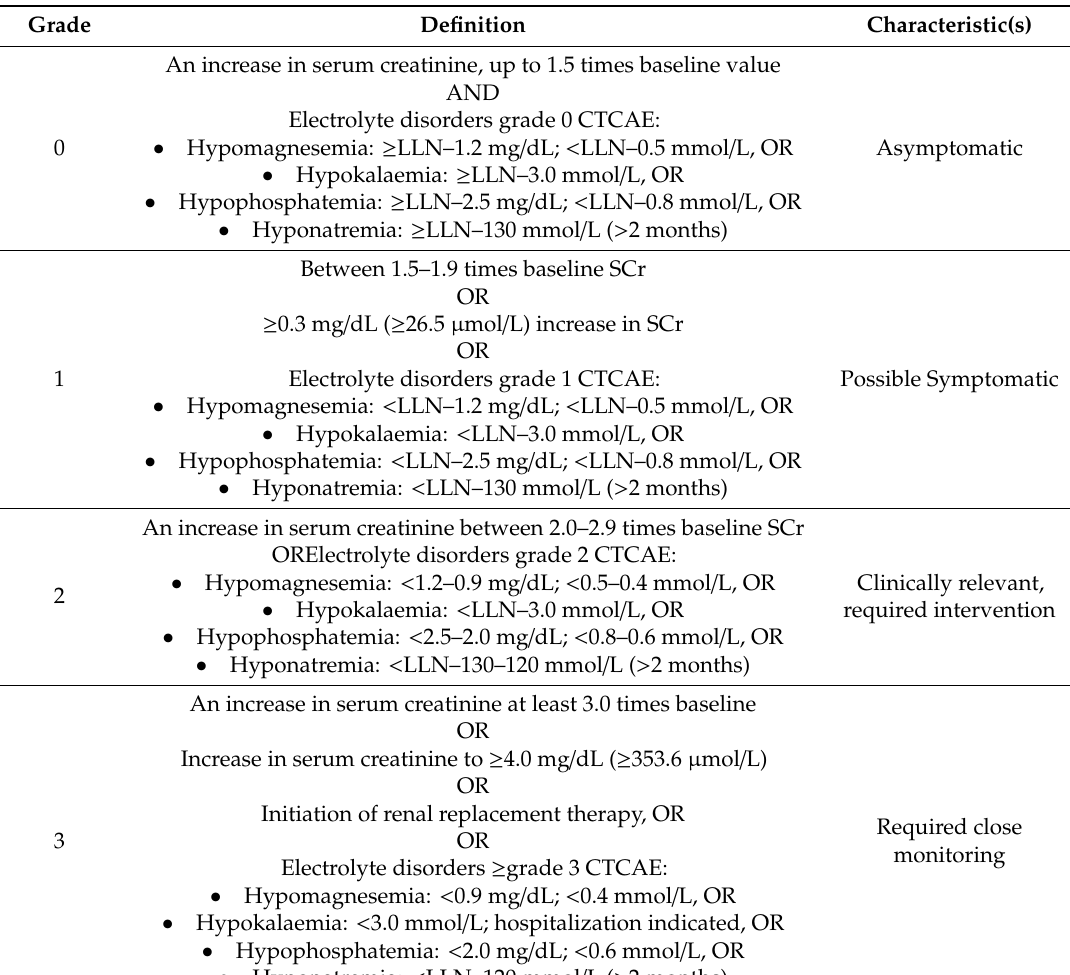
Table 1. Adjusted Acute Kidney Injury (Adjusted-AKI) grading.